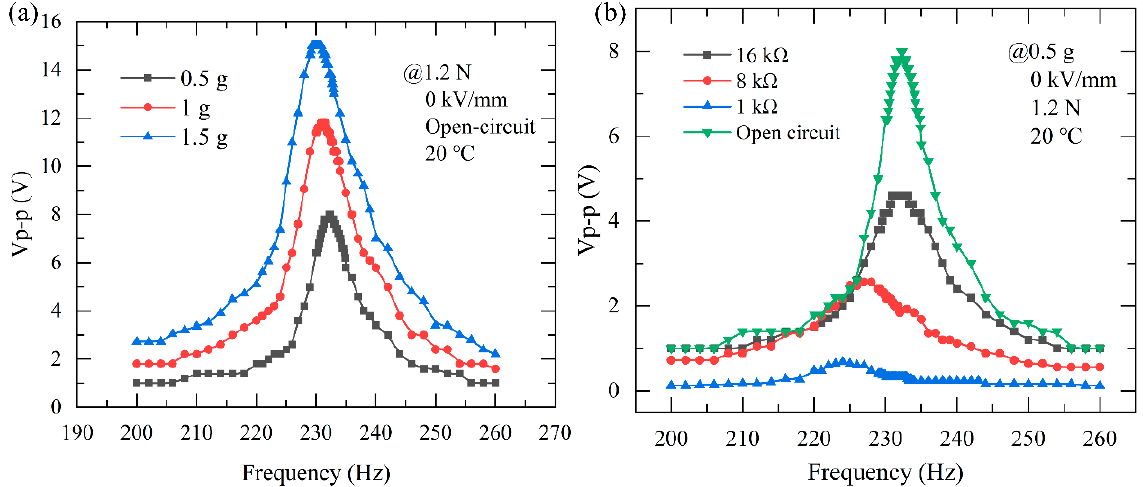
Figure 4. The output performance of the PEH. ( a ) Output response voltage as a function of frequency under different acceleration; ( b ) Output response voltage with various load resistances.